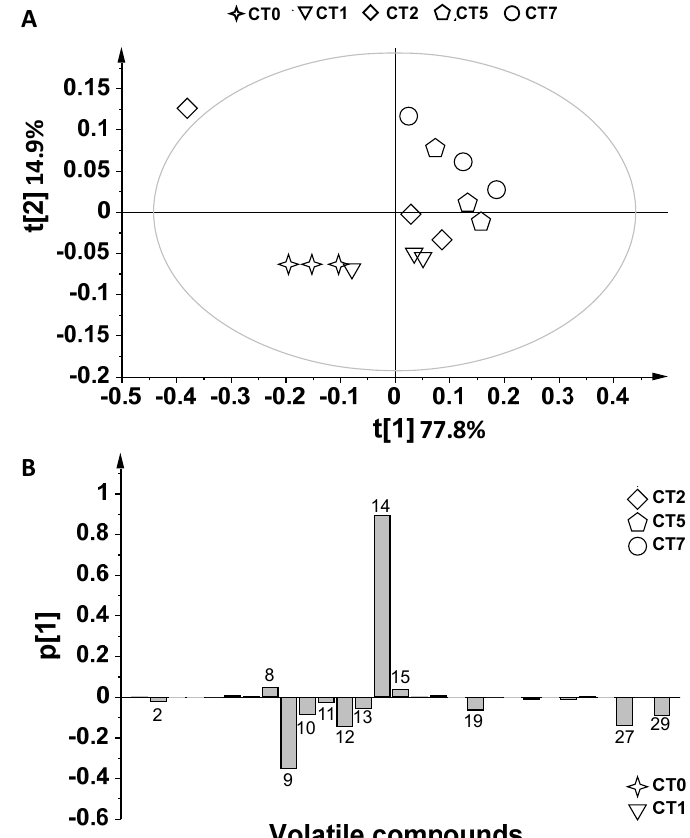
Figure 2. ( A ) PCA t[1]/t[2] score plot of SPME-GC/MS of CT samples analyzed at Days 0, 1, 2, 5 and 7; ( B ) p[1] loading plot for the t[1]/t[2] score plot of PCA. Positive values: metabolites detected at Days 5 (CT5) and 7 (CT7); negative values: metabolites detected at Days 0 (CT0) and 1